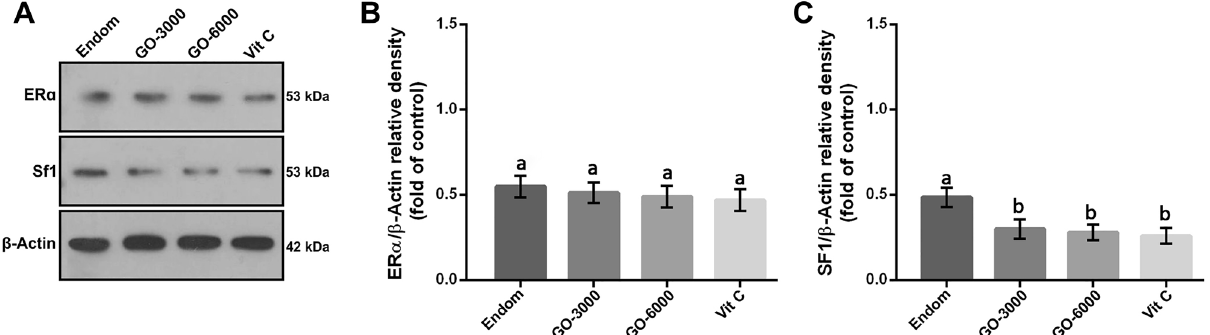
Figure 1. Effect of gamma-oryzanol on relative protein expressions assessed by Western blot. Representative Western blot bands of ER-α, SF1 and β-actin ( A ) and the relative protein expression of ER-α ( B ) and SF1 ( C ) in experimental groups. These proteins were normalized by β-actin and reported as relative change compared to endom-group. The results showed that the expression of SF1 decreased in the treated groups compared to the endom-group ( P < 0.05). The superscripts (a–e) display differences among